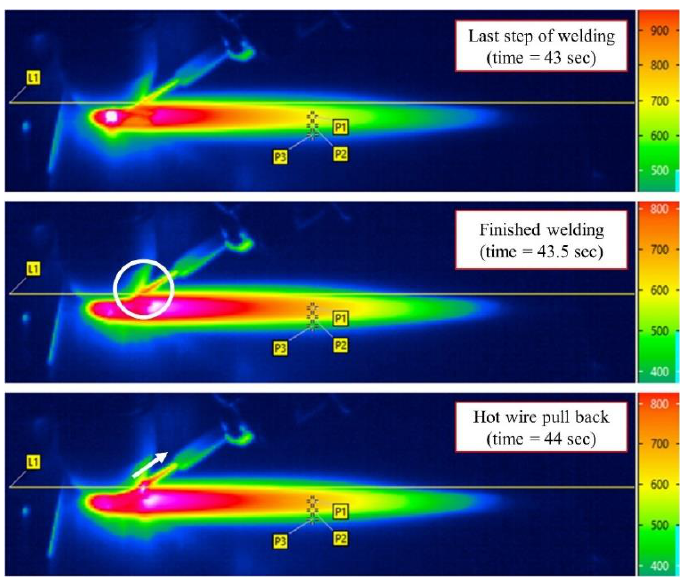
Figure 14. The captured image while the hot wire pulls back.